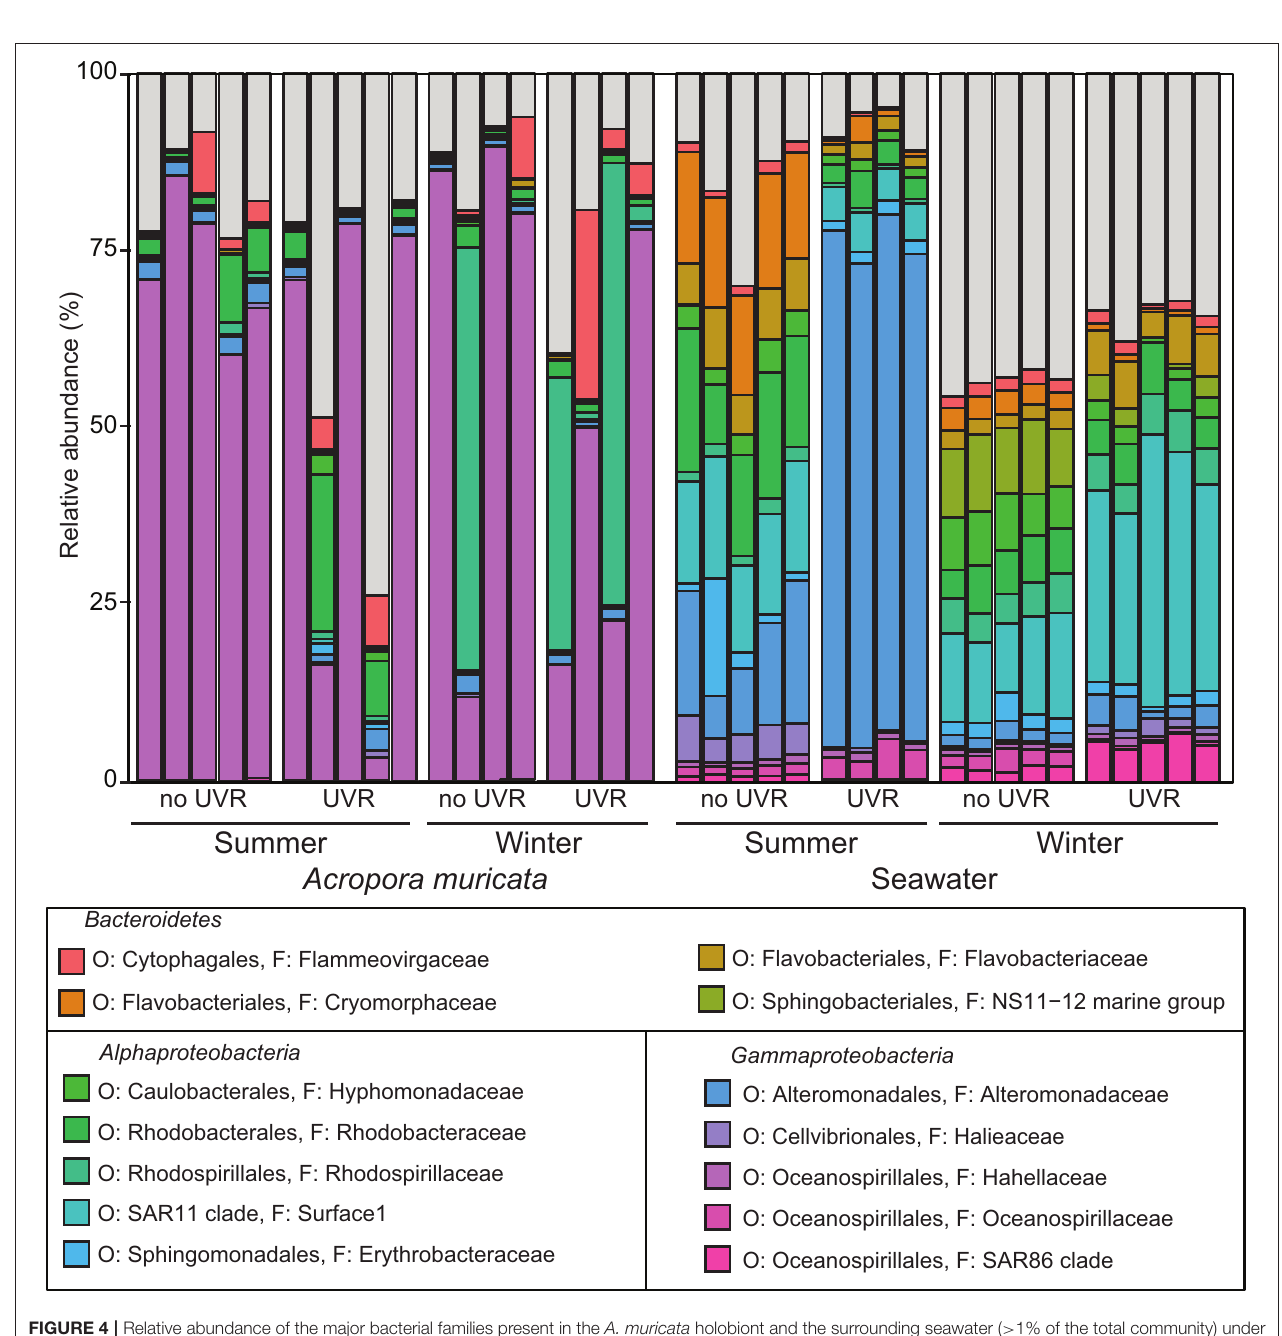
FIGURE 4 | Relative abundance of the major bacterial families present in the A. muricata holobiont and the surrounding seawater ( > 1% of the total community) under ambient or no UV radiation at two contrasting seasons (summer and